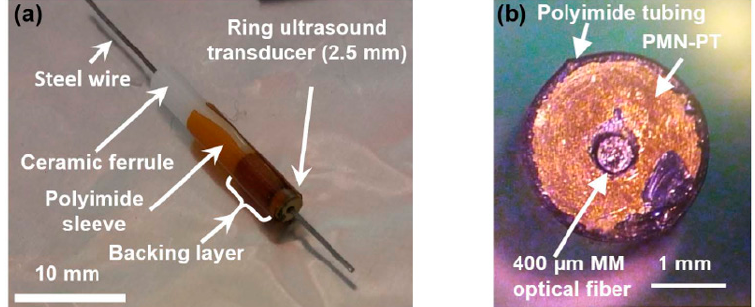
Figure 11. Optical image of the photoacoustic transducer device ( a ) and the front view of the pMUT surface ( b ) (Reproduced with permission from IEEE [103]).